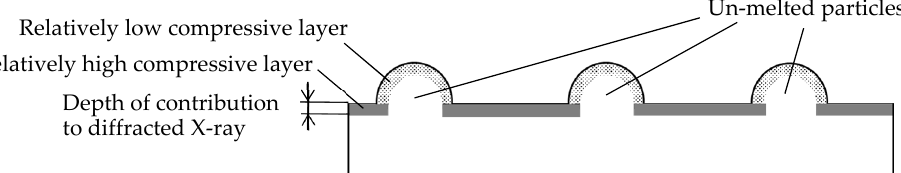
Figure A2. Schematic diagram of X-ray diffraction, considering the surface roughness and depth of the contribution to the diffracted X-ray.